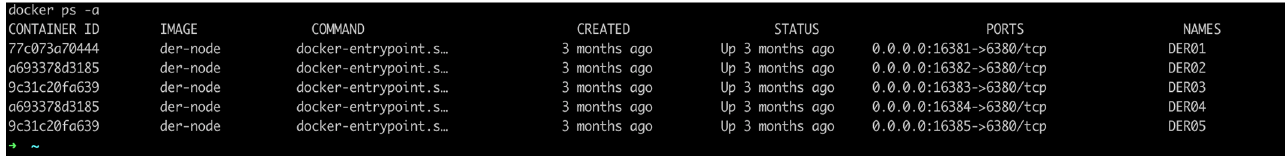
Figure 10. The deployment of projects based on docker.